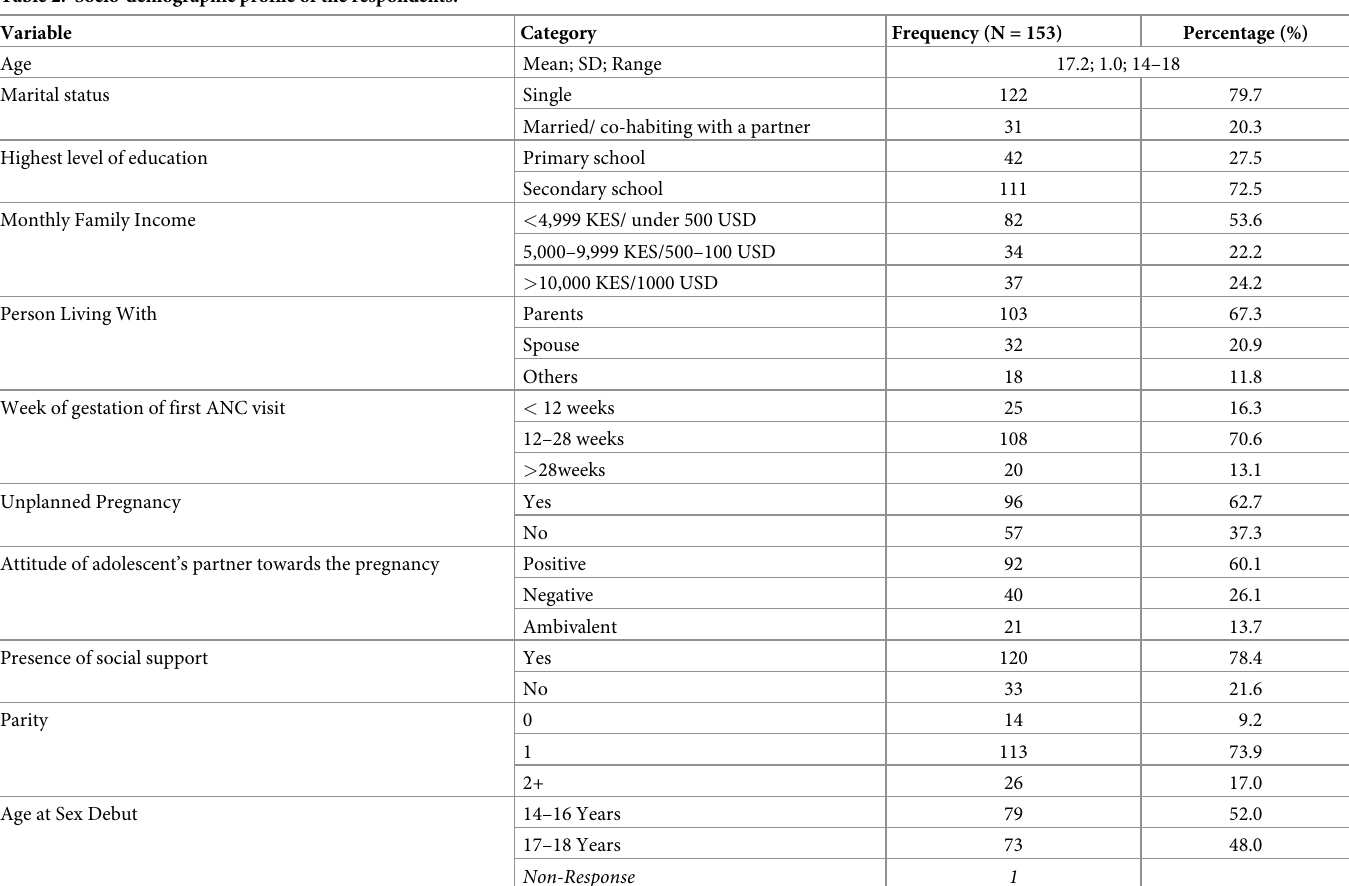
Table 2. Socio-demographic profile of the